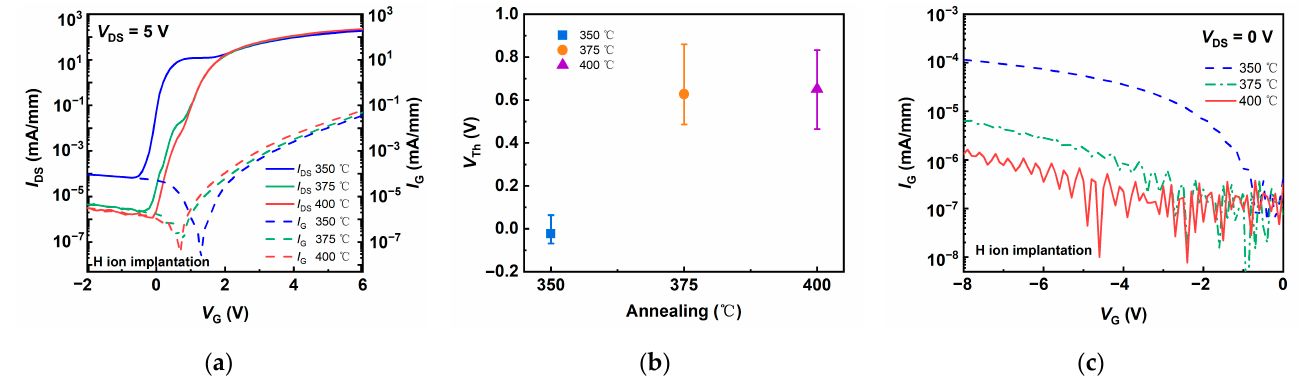
Figure 4. ( a ) Transfer characteristics at log scale; ( b ) average values and errors of threshold voltages; ( c ) gate leakage characteristics at the negative bias of p-GaN HEMTs obtained via H ion implantation, after annealing at 350, 375, and 400 °C.